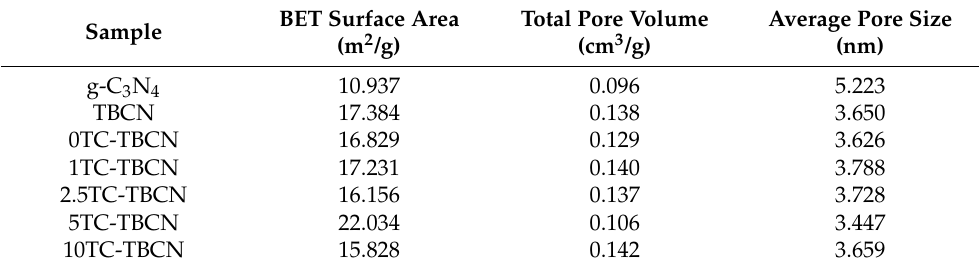
Table 1. BET surface areas, total pore volumes and average pore sizes of the obtained products.